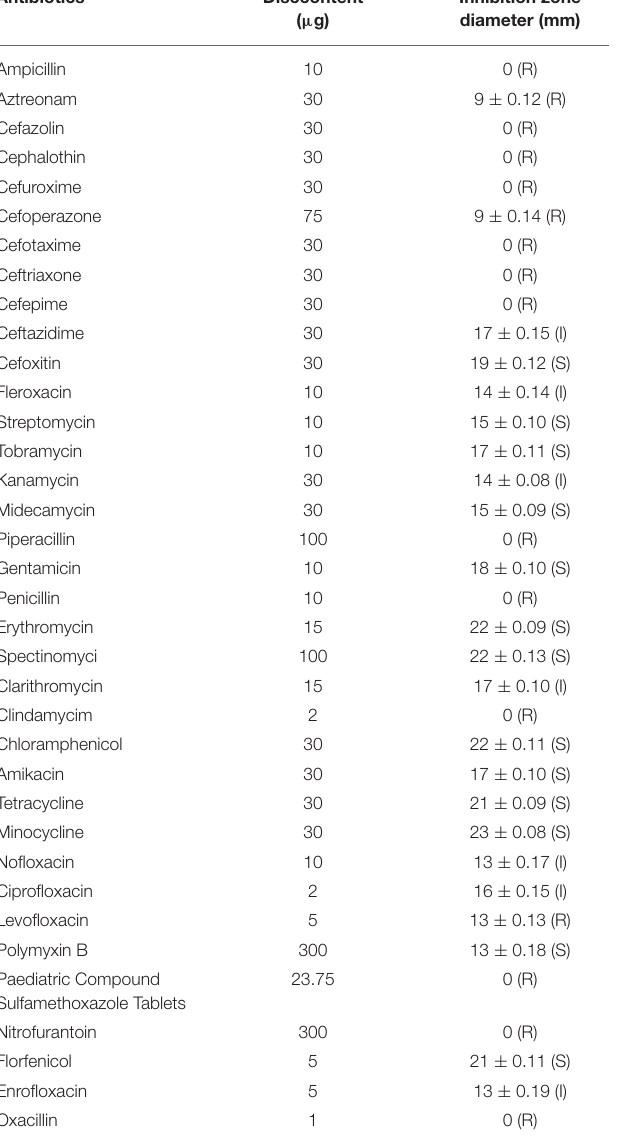
TABLE 3 | Antibiotic resistance of non-O1/O139 V. cholera GXFL1-4. TABLE 4 | The antibiotic resistance genes of the strain GXFL1-4 annotated in